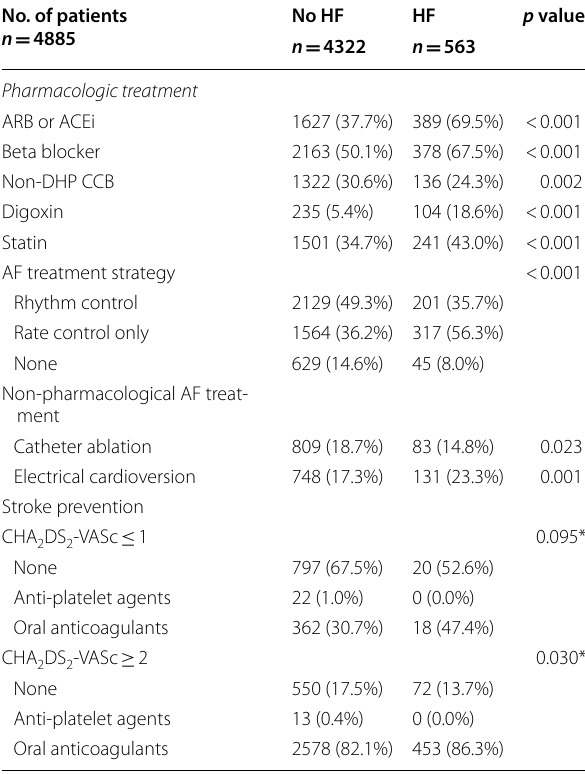
Table 2 Treatment strategies according to the